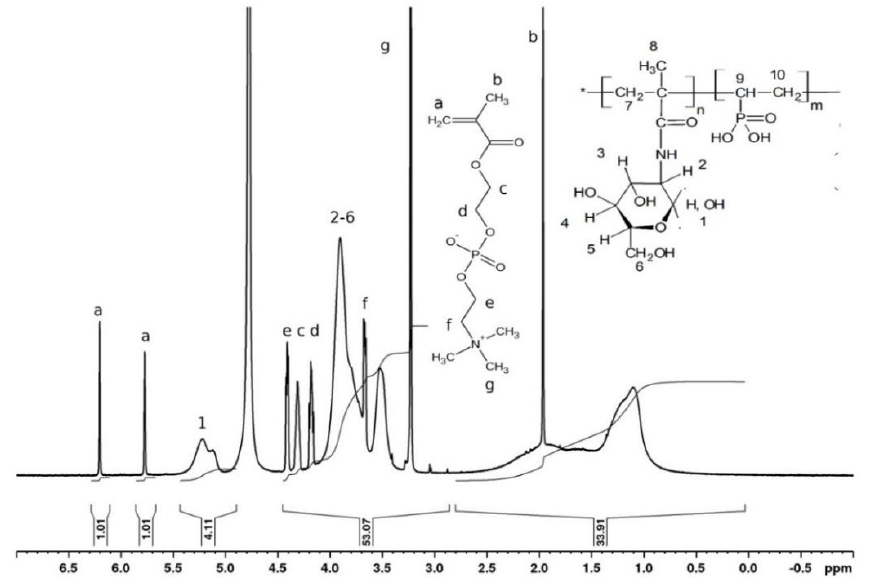
Figure 6. 1 H NMR spectrum of the mixture containing MAG–VPA copolymer (Experiment 3, Table 1) Figure 6. 1 Н NMR spectrum of the mixture containing MAG– VPA copolymer (Experiment 3, Table and MPC in D 2 1) and MPC in D 2 O.